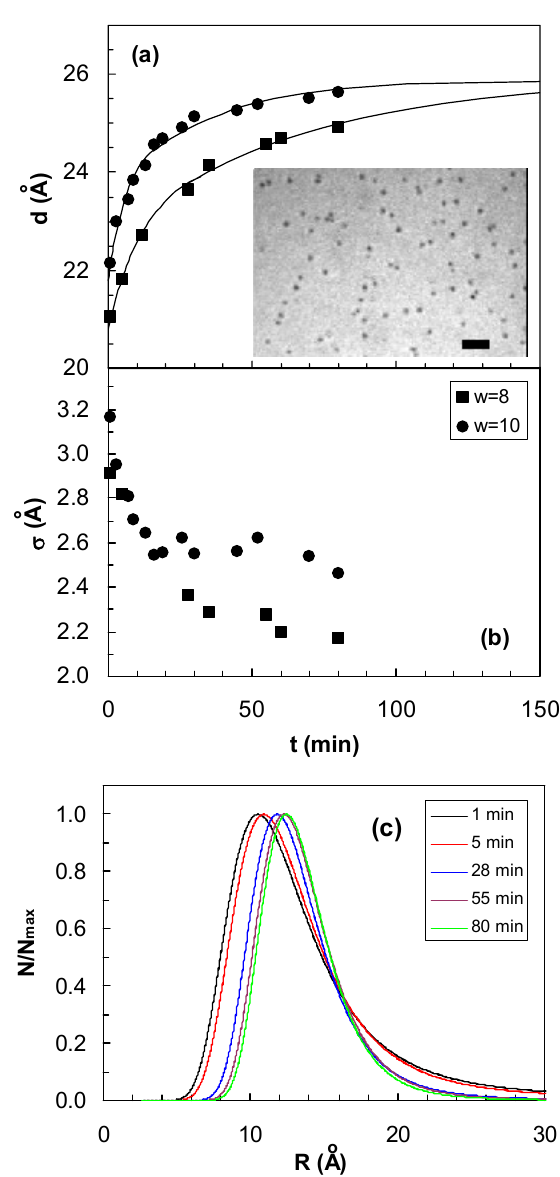
Fig. 5 Kinetics of growth of CdSe nanoparticles (the data points are extracted from Fig. 4a,b). (a) The mean diameter d is plotted versus time. The inset shows TEM image of the final CdSe nanoparticles, which are readily seen as the black spots ( w =10; scale bar 20 nm). The average diameter obtained from this image ( d =3.12 nm) corresponds roughly to that calculated from the optical spectra ( d =2.65 nm). (b) Plot of the dispersion σ versus the time. σ is determined from the peaks in (c) by taking its width at 0.6 height from the bottom and dividing by 2. (c) Evolution of the size distribution of CdSe nanoparticles at w =8. The peaks are calculated as described in ref.